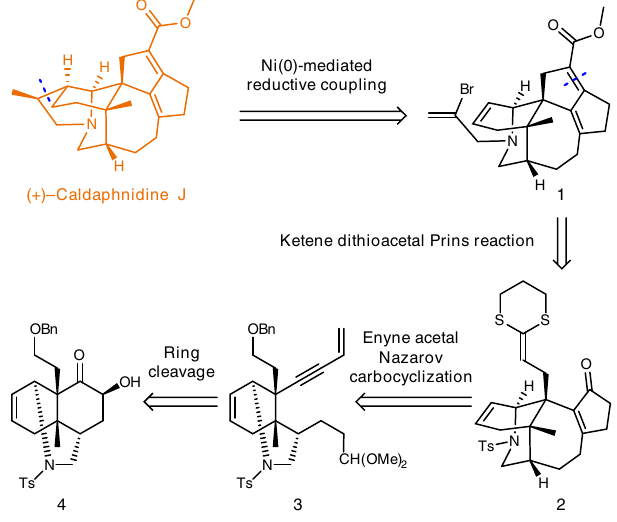
Fig. 2 Retrosynthetic analysis of ( + )-caldaphnidine J. The key disconnections include a Ni(0)-mediated reductive coupling reaction, a ketene dithioacetal Prins reaction, an enyne acetal Nazarov carbocyclization and a ring cleavage